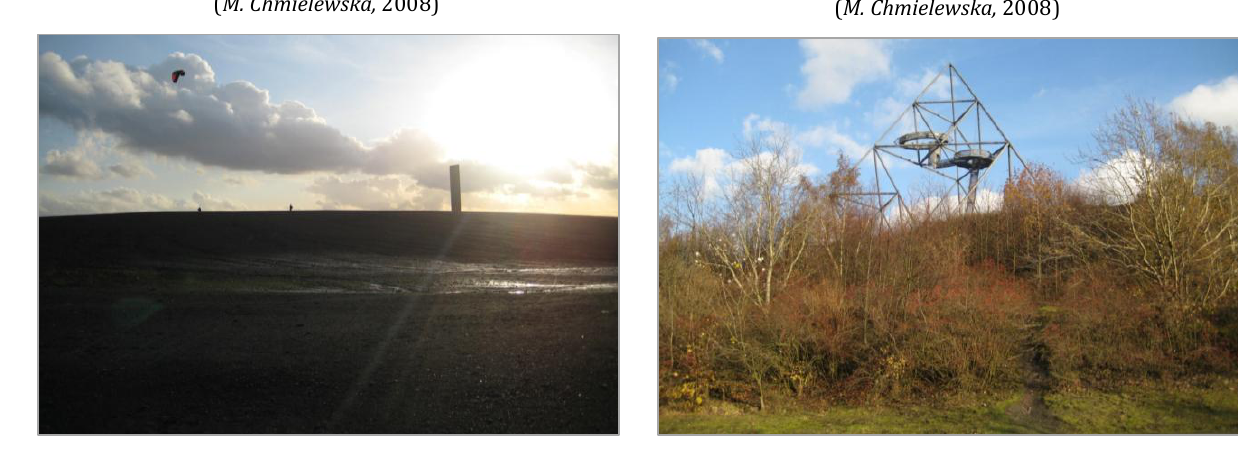
Fig. 4. Banks around the pond on the Schurenbach tip